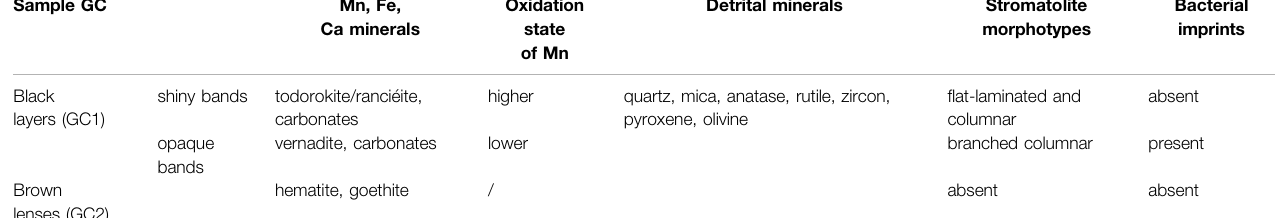
TABLE 1 | Distribution of the mineralogy, oxidation state of Mn, stromatolite-like structures, and bacterial imprints between the black layers (shiny and opaque bands) and brown lenses, obtained integrating SEM-EDS, XRPD, FT-IR, and Raman spectroscopy results. Sample GC